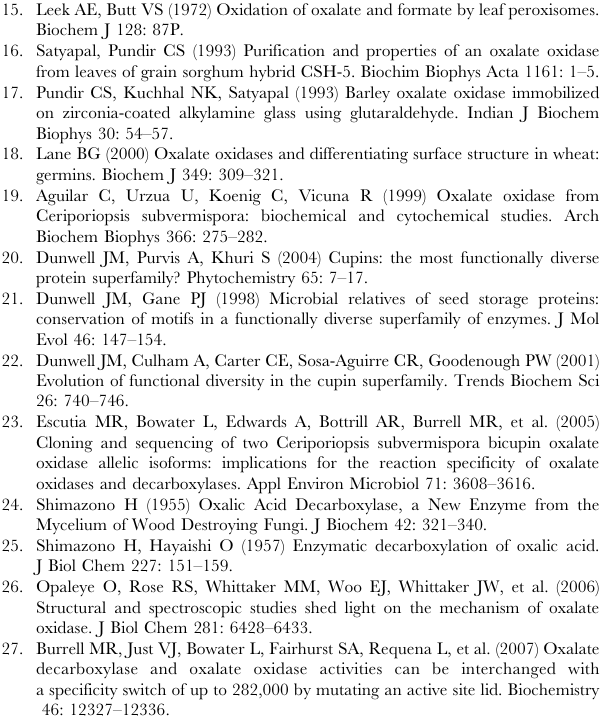
Figure S1 Sequence alignment of CsOxOx and OxDC. Sequence alignment of Bacillus subtilis oxalate decarboxylase Asterisks indicate identical residues, colons (:) indicate conservative substitutions, and periods (.) indicate semi-conservative substitu- tions. The conserved cupin motifs are shown (motif 1 in blue and motif 2 in red) in the two domains. The ‘‘lid’’ region is shown in green. The Mn-binding residues are underlined. Figure S2 Frequency dependence of recombinant, wild- type CsOxOx in 25 mM Imindazole-Cl, pH 7.0. A: 104.0 GHz. B: 208.0 GHz. C: 326.4 GHz. D: 416.0 GHz. Figure S3 X-band EPR spectrum of wild-type CsOxOx enzyme in 25 mM Imidazole-Cl, pH 7.0. The experimental and simulated spectra are displayed in blue and red, respectively. Figure S4 104.0 GHz EPR spectrum of wild-type CsOxOx enzyme in 25 mM Imidazole-Cl, pH 7.0. The experimental and simulated spectra are displayed in blue and red, respectively.